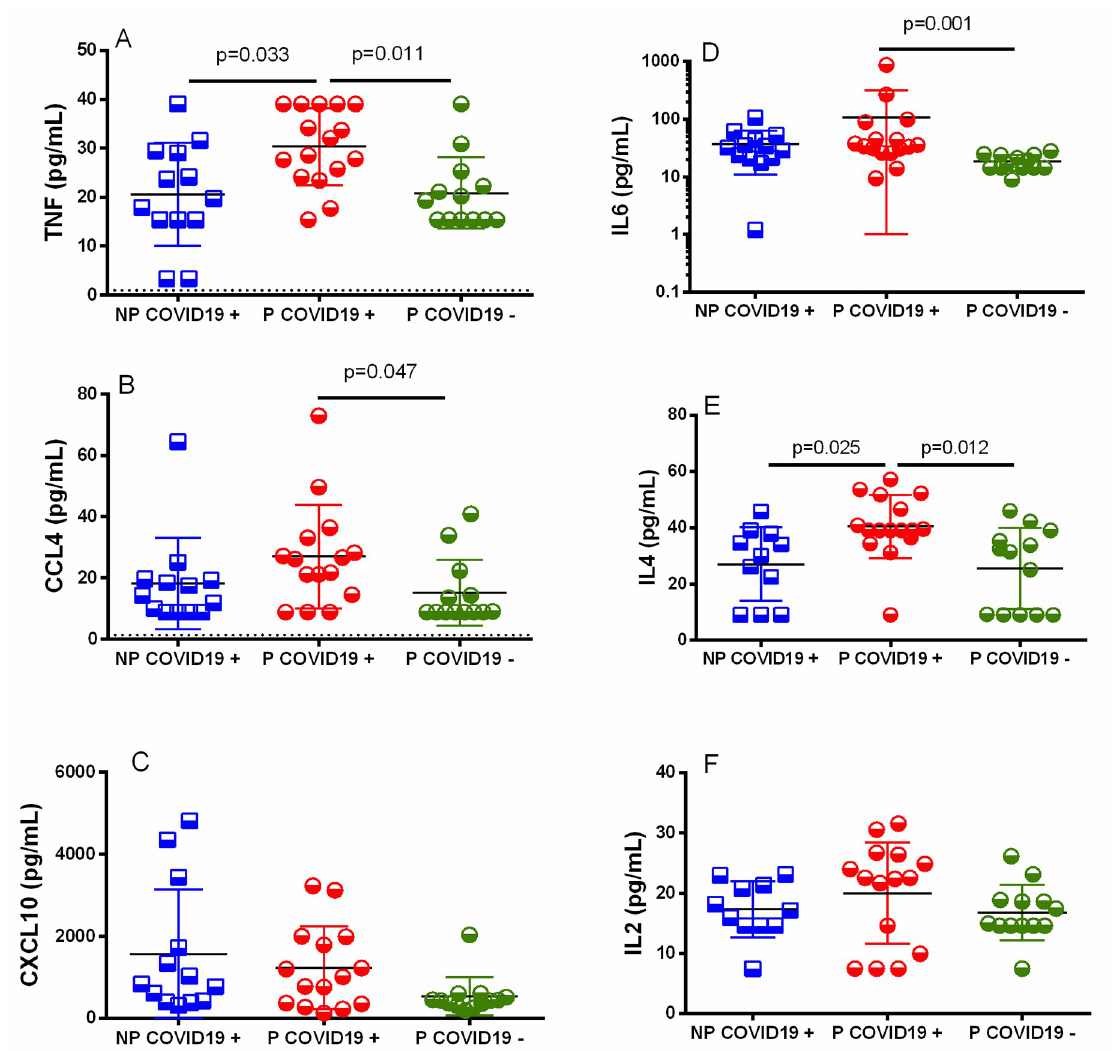
Fig 3. Cytokine/chemokine serum concentration. Serum was isolated, and cytokine/chemokine concentrations were determined using bead-based immunoassays as described in the methods. The results are expressed as the mean ± SD. Significance value was p < 0.05. Kruskal– Wallis and Dunn’s multiple comparisons tests were calculated. Non-Pregnant COVID-19 positive (NP-COVID-19+, n = 13). Pregnant COVID-19 positive (P-COVID-19+, n = 14–15). Pregnant COVID-19 negative (P-COVID-19-, n =